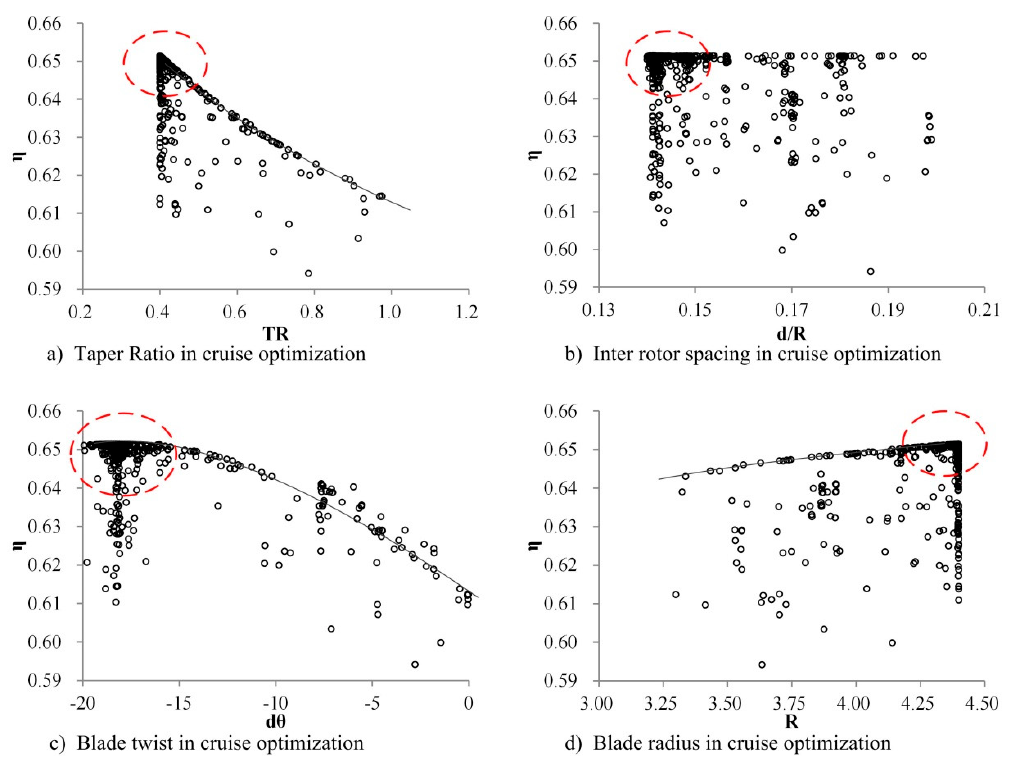
Figure 12. Parameters of optimization samples in cruising state.